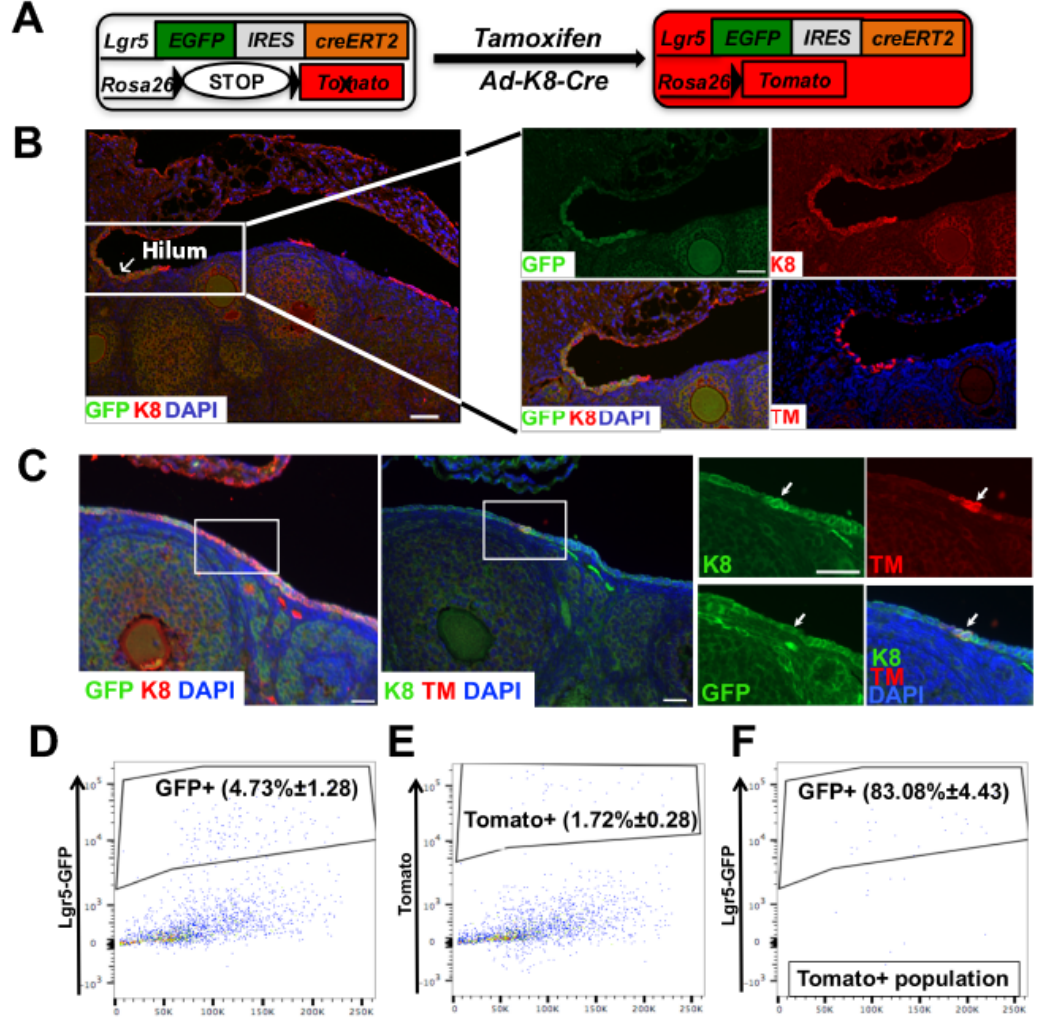
Figure 2. Ad-K8-Cre preferentially targets LGR5 + OSE cells. ( A ) Schematic diagram showing the activation of the Tomato reporter in the Lgr5-GC;R26tdTm model, either upon tamoxifen-induced activation of CreER in Lgr5-GC or upon Cre expression from the injected Ad-K8-Cre virus. ( B , C ) Rep- resentative images of the ovarian hilium region ( B ) and OSE region ( C ) from Lgr5-GC;R26tdTm mice showing K8, GFP ( Lgr5 ), TM (Tomato) ( Ad-K8-Cre -infected cells), and DAPI staining 2 weeks after Ad-K8-Cre intrabursal injection. Arrows indicate GFP ( Lgr5 ) and K8 double-positive cells. Scale bars = 50 µ m. ( D – F ) FACS analysis of OSE cells from Lgr5-GC;R26tdTm mice 4 days after Ad-K8-Cre injection showing GFP ( Lgr5 ) + cells ( D ), Tomato + cells ( E ), and GFP + Tomato + cells ( F